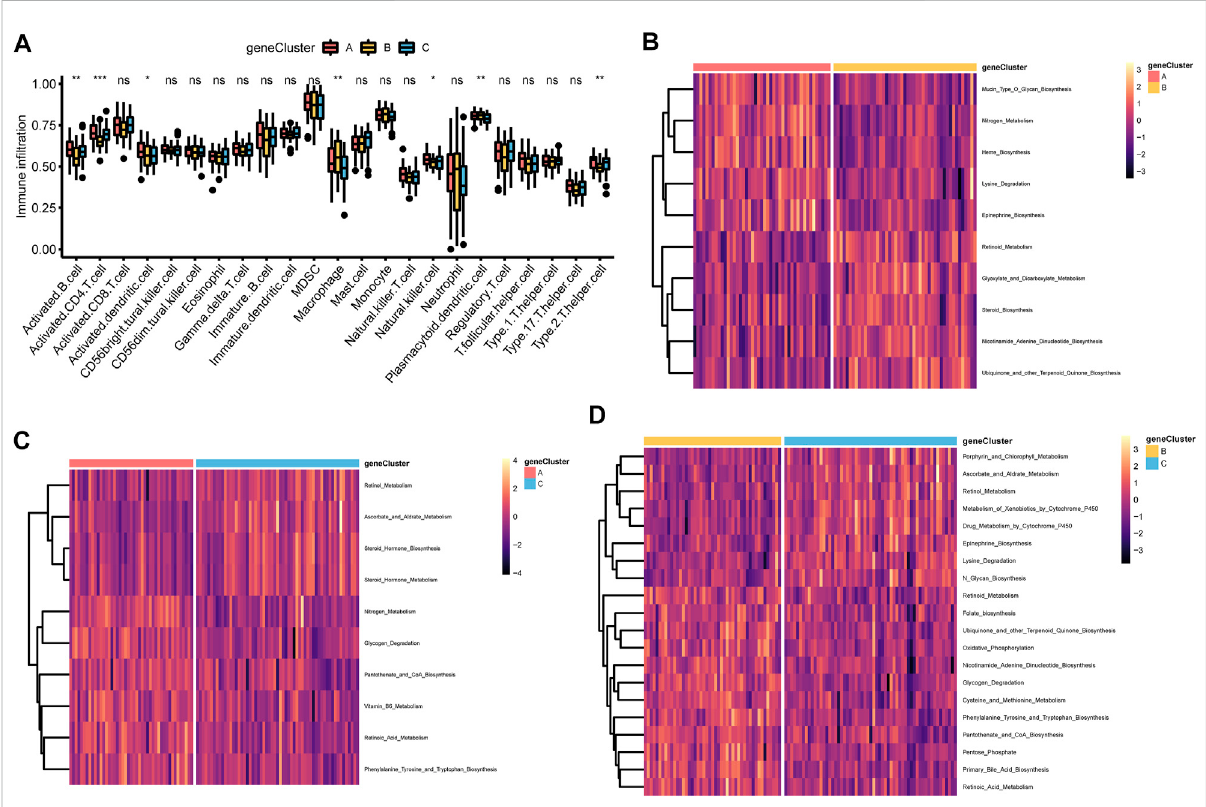
Correlations of TME and three m6A gene clusters (A) The fraction of tumor-in fi ltrating lymphocyte cells in three m6A gene clusters using the CIBERSORT algorithm. Violin plots illustrated the differences in the immune cell distribution across three m6A gene clusters. * p < 0.05, ** p < 0.01, *** p < 0.01, ns, not signi fi cant (B – D) Heatmap was plotted to show the activation states of biological pathways in three m6A gene clusters via the GSVA enrichment analysis. B, m6A gene cluster A vs. m6A gene cluster B;C, m6A gene cluster B vs. m6A gene cluster C; D, m6A gene cluster A vs. m6A gene cluster